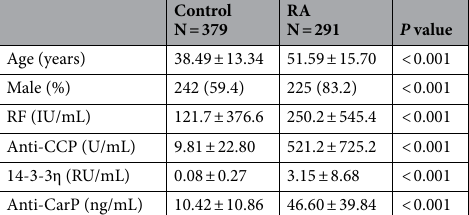
Table 1. Basal characteristics of study